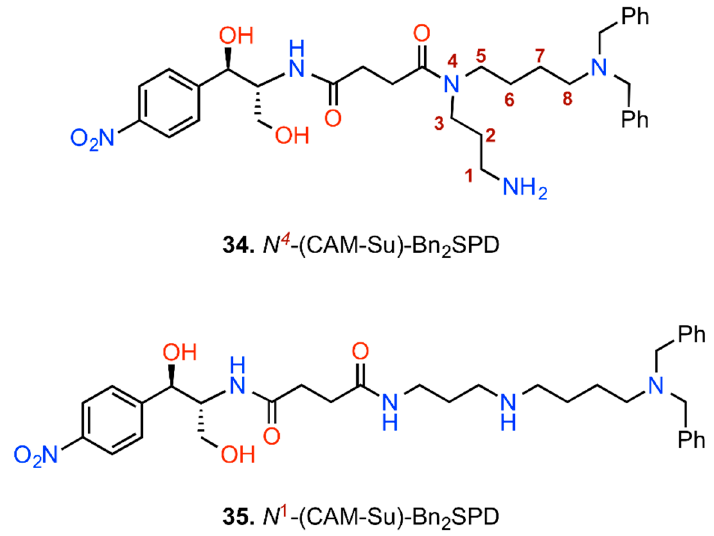
Figure 9. CAM-polyamine conjugates.